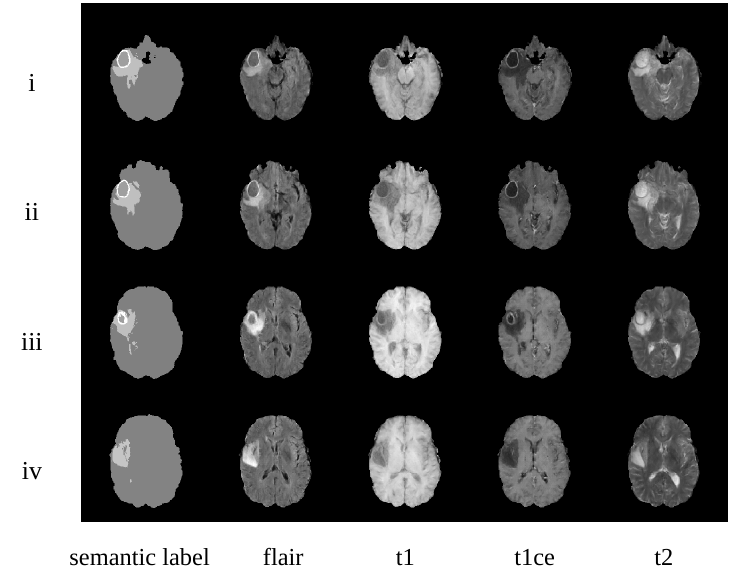
Figure 7. Examples of synthetic images from one patient. i–iv represent slices 52, 58, 66, and 73 from this patient, respectively. Images from the left to the right are the corresponding semantic labels and four synthetic modality images (i.e., flair, t1, t1ce, and